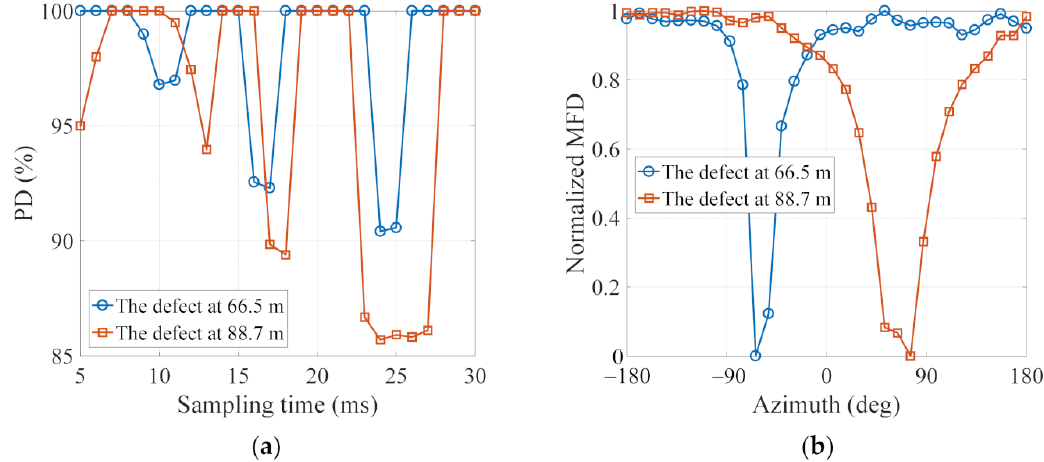
Figure 14. Inspected PDs and normalized MFDs for two asymmetry defects: ( a ) Inspected PDs at different sampling times; ( b ) normalized MFDs at 10 ms.